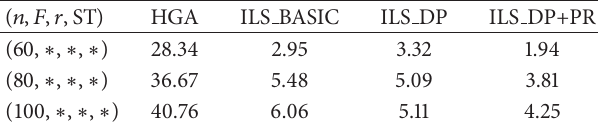
Table 6: Average RDIs (%) for instances grouped by number of families ( 𝐹 ).